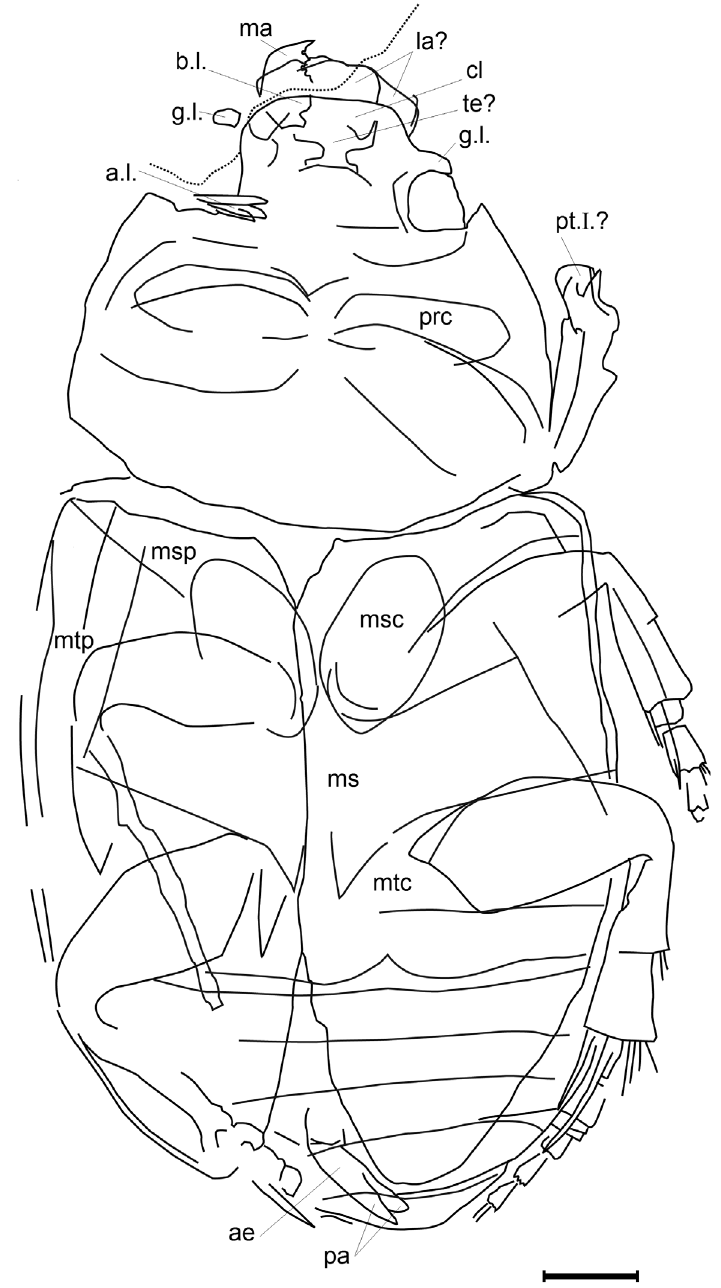
Figure 2. Ceafornotensis archratiras gen. and sp. n.: holotype BP/2/18654, habitus. Abbreviations: ae – aedeagus, a.l. – antennal lamellae, b.l. – basal lobe of mandible, cl – clypeus, g.l. – genal lobe, la? –